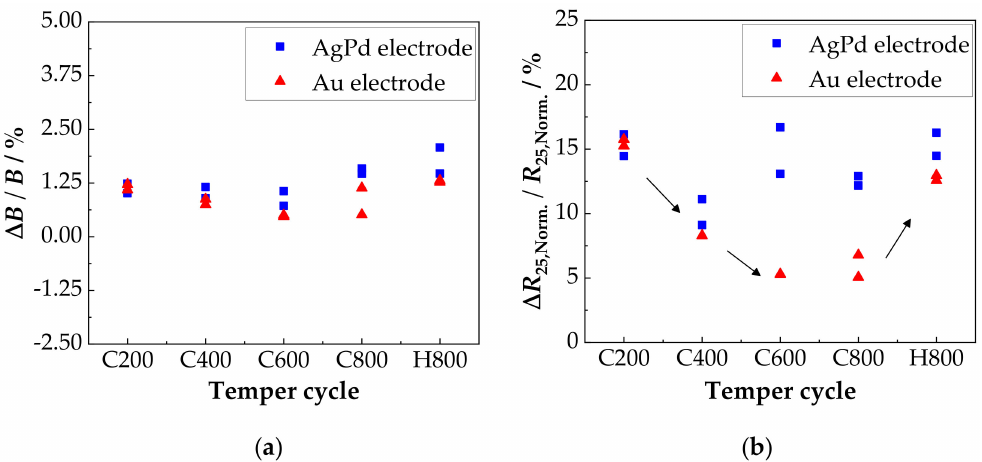
Figure 10. Aging resistance as it depends on a previous temper process: Comparison of the relative change of ( a ) B and ( b ) R 25,Norm. relative to the tempered state ( t Aging = 0) after 1000 h aging at 125 ◦ C in air for the samples deposited on electrode materials AgPd and